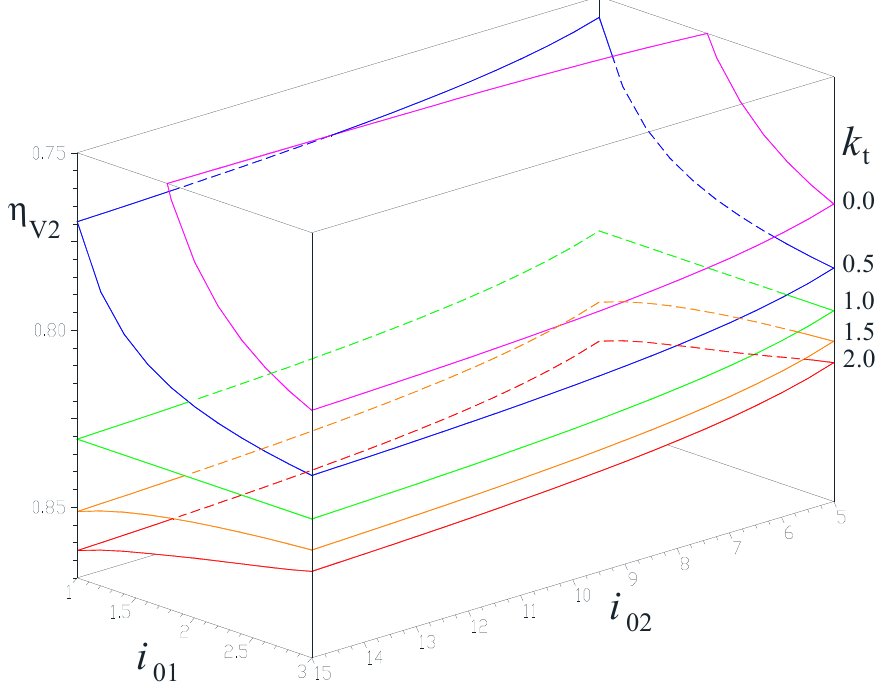
Figure 7. Efficiency of the 1-DOF speed increaser variant V2 (Figure 5b), as functions of the interior kinematic ratios i 01 and i 02 , for torque ratios k t = 0, 0.5, 1.0, 1.5 and 2.0, assuming η 0 = 0.965.